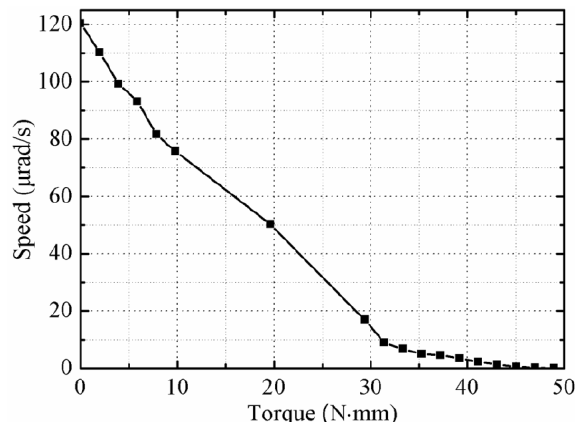
Figure 12. Plot of the speed versus the torque.